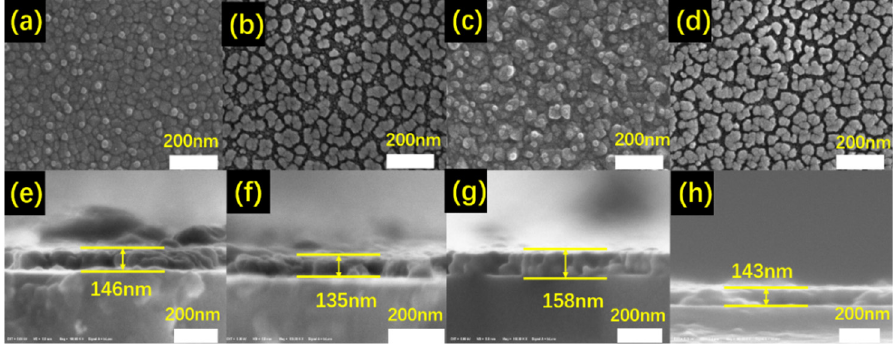
Figure 3. SEM images of the surface morphology of ( a ) sample ZrO 2 -60 W, ( b ) sample ZrO 2 -60 W- acid, ( c ) sample ZrO 2 -90 W, and ( d ) sample ZrO 2 -90 W-acid; cross sections of ( e ) sample ZrO 2 -60 W, ( f ) sample ZrO 2 -60 W-acid, ( g ) sample ZrO 2 -90 W, and ( h ) sample ZrO 2 -90 W-acid.